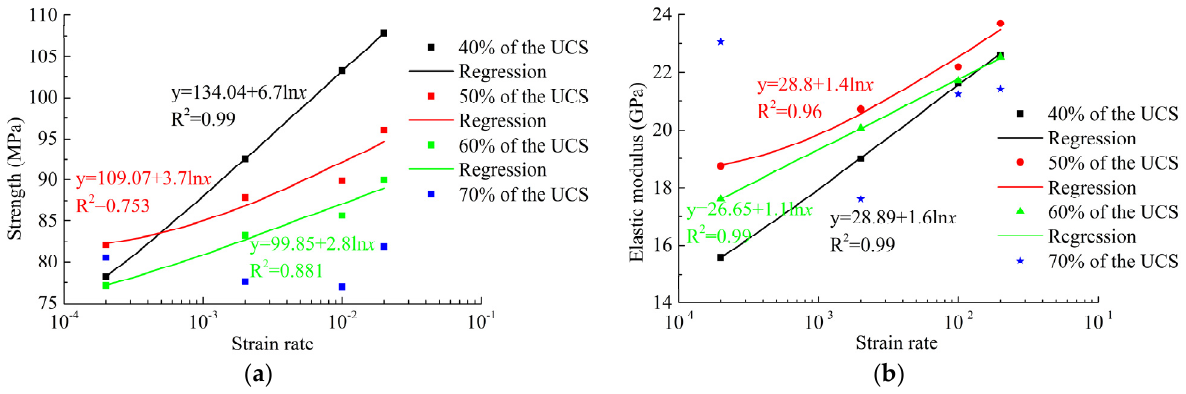
Figure 7. The ( a ) strength and the ( b ) elastic modulus influenced by the dynamic loading rate.